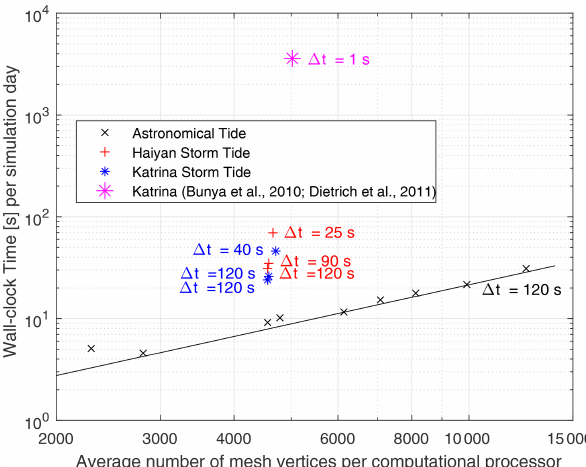
Figure 14. Computational wall-clock times for the various mesh de- signs and experiments versus the average number of mesh vertices per computational processor. All simulations were computed on 480 computational processors (i.e., the variation in vertices per proces- sor comes from the variation in the total number of vertices for each mesh design). The computational performance in this study using ADCIRC v55 is contrasted with previous ADCIRC model Katrina storm tide simulations (Bunya et al., 2010; Dietrich et al., 2011) that required very small time steps ( (cid:49)t =